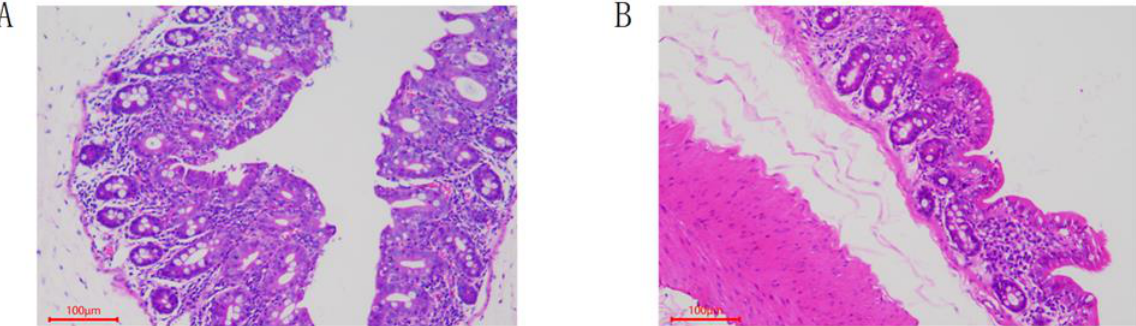
Figure 1. Pathological observation of cecum tissue in rabbits by microscope (HE-staining, 100×). ( A ) Dia_Ce. ( B ) Con_Ce.